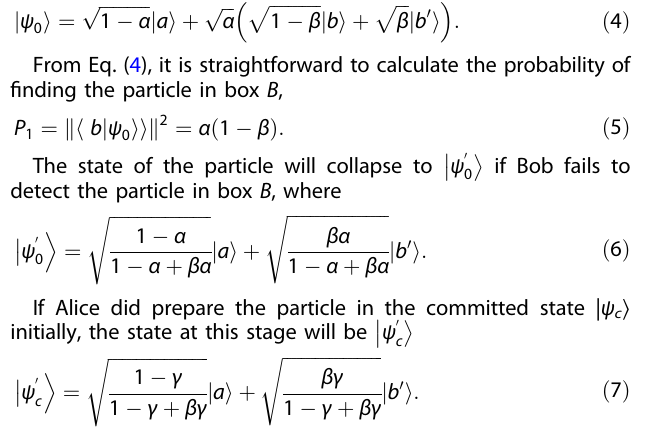
ffiffiffiffiffiffiffiffiffiffiffi p 1 (cid:1) α